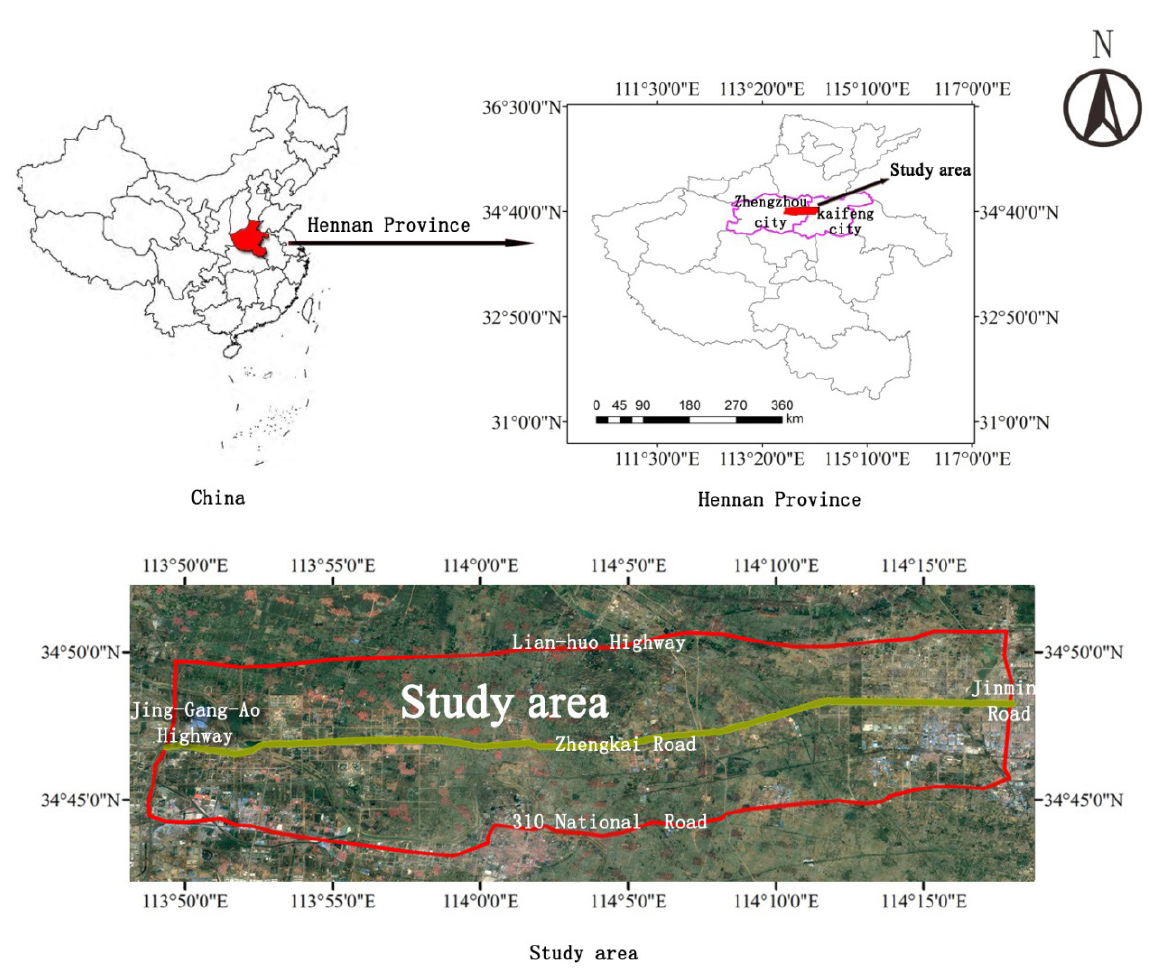
Figure 1. Location and range of the study